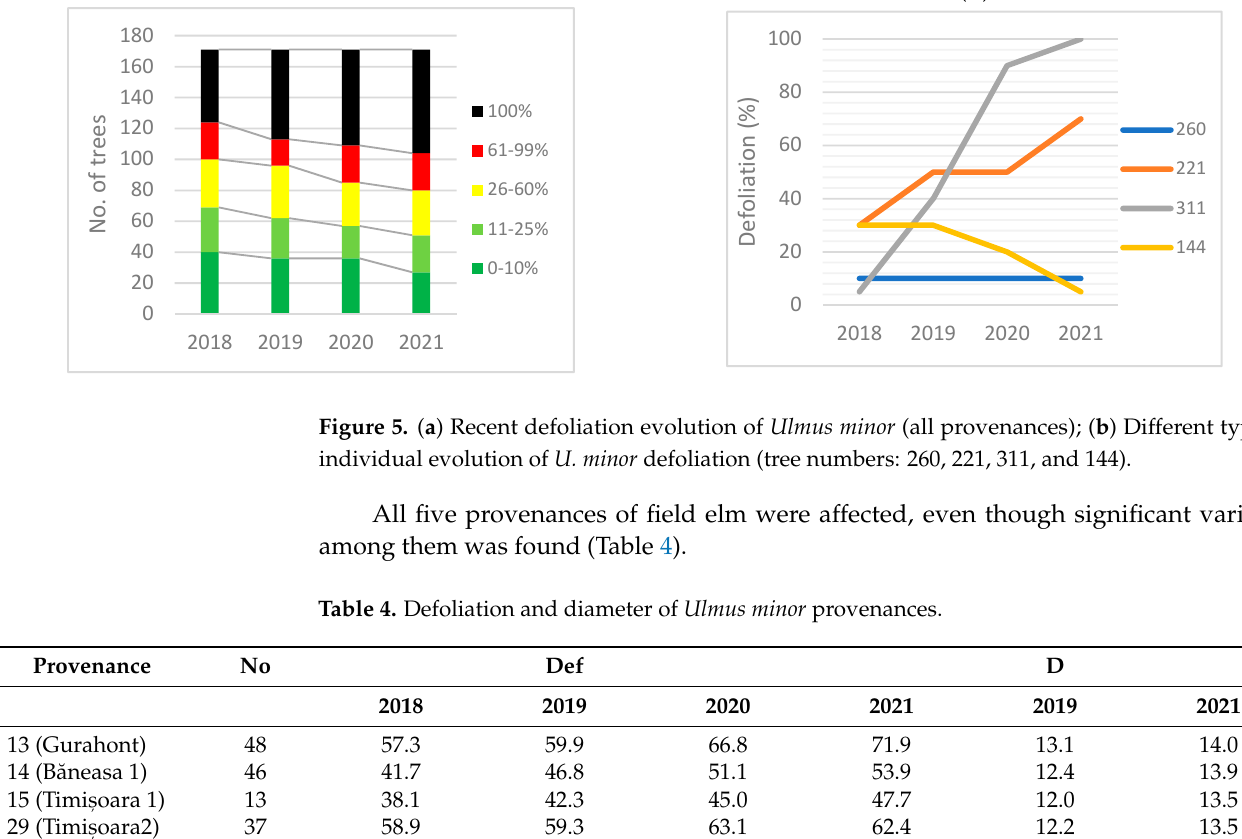
Table 5. Defoliation and diameter of Ulmus glabra provenances.